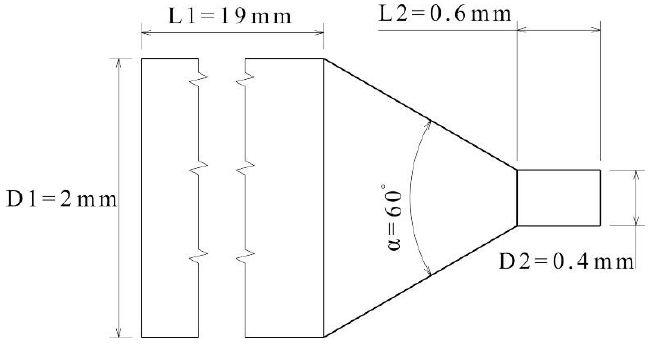
Figure 1. Cross-section of the nozzle and the relevant dimensions.